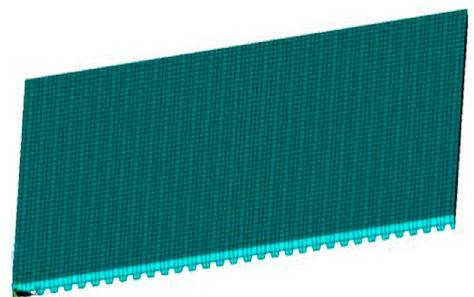
Figure 19. FE model of benchmark laboratory floor.